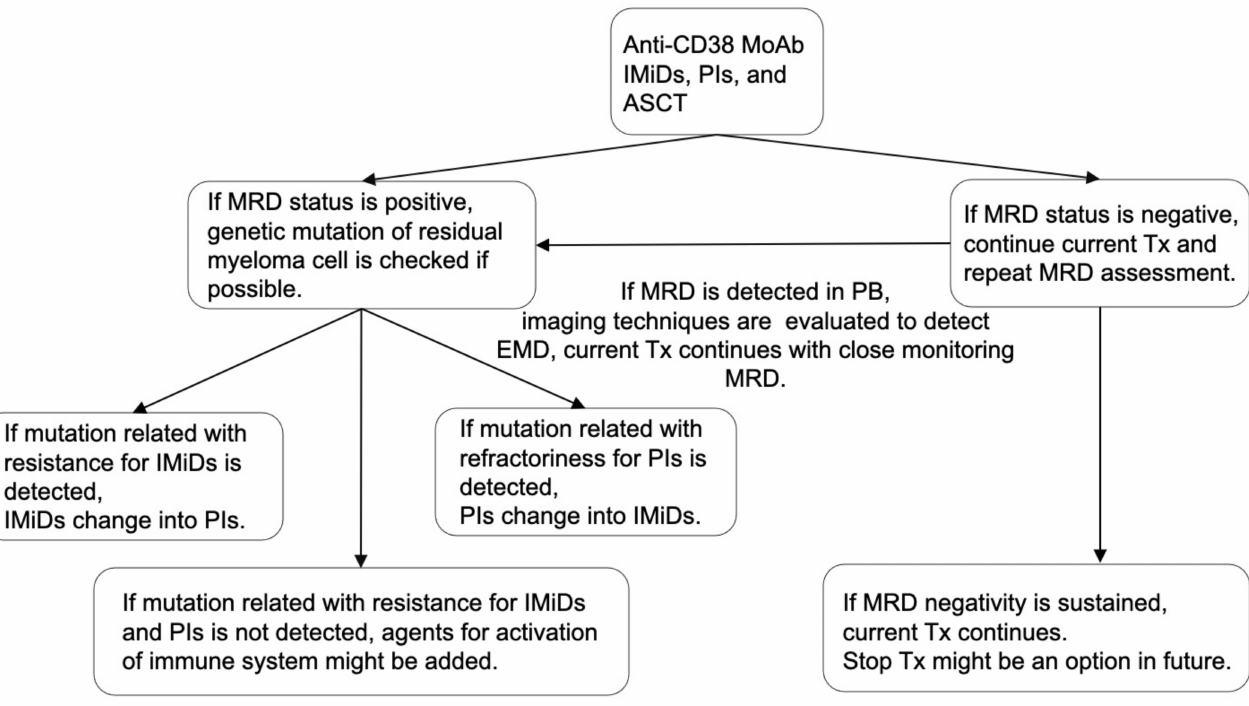
Figure 2. Treatment algorithm concerning MRD and immunological status. Combination therapy with anti-CD38 MoAb, IMiDs, PIs, and ASCT may be suitable for MM patients considering the efficacy against myeloma cells and improved immune system. If the MRD status is negative, the current treatment should continue. However, if the MRD status is positive, the genetic mutation of residual myeloma cells should be analyzed to optimize treatment. If mutation related with resistance for IMiDs or PIs is detected, treatment should be changed. If mutation related with resistance for IMiDs or PIs is not detected, agents for activation of immune system might be added. MRD assessment should be repeated in the patients with MRD negativity. If MRD status convert into positivity in PB sample, imaging technique should be evaluated to detect EMD. Thereafter, the current Tx could continue with close monitoring MRD status. MRD, minimal residual disease; IMiDs, immunomodulatory drugs; PIs, proteasome inhibitors; MoAbs, monoclonal antibodies; ASCT, autologous stem cell transplantation; Tx, treatment; PB, peripheral blood; and EMD, extramedullary